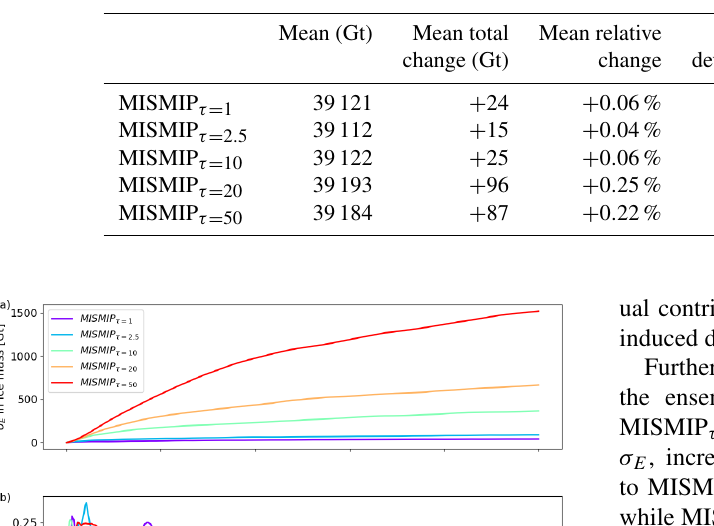
Table 4. Statistics of the final ice mass distributions for the five MISMIP+ transient ensembles. The relative change is calculated with respect to the initial ice mass (39097Gt).